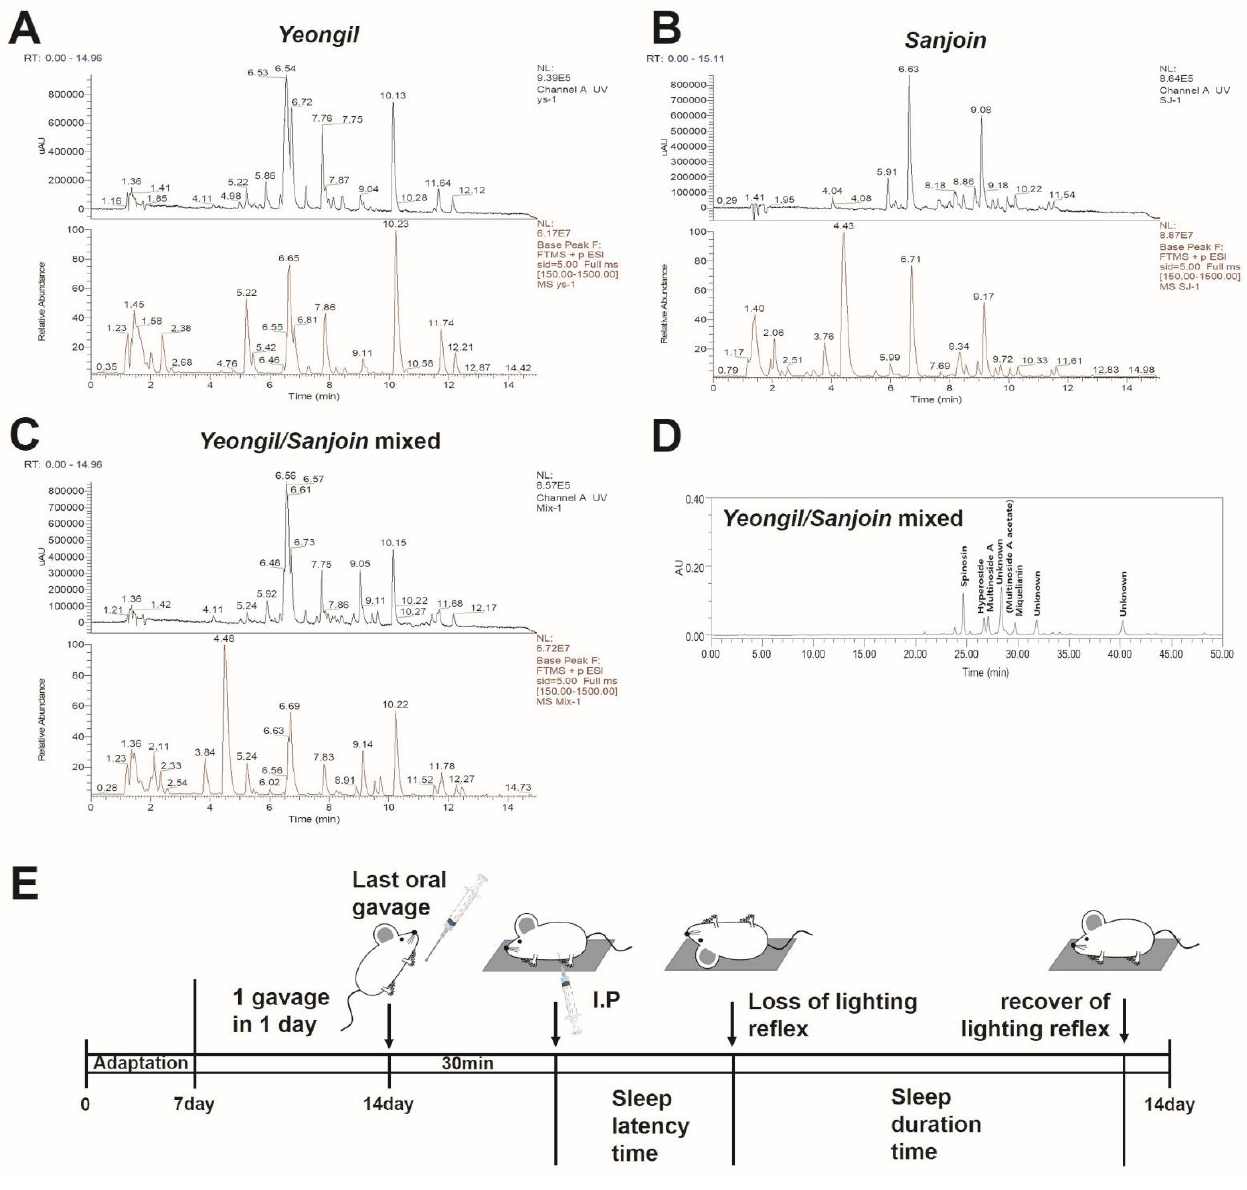
Figure 1. Confirmation of active ingredients through LC-MS analysis and anesthetic sleep. The LC-MS result of Rosa multiflora Thunb. (Yeongsil) ( A ). The LC-MS result of Zizyphus jujuba Miller (Sanjoin) ( B ). The LC-MS result of NCP mixed with Rosa multiflora Thunb. (Yeongsil) and Zizyphus jujuba Miller (Sanjoin) in a ratio of 6:4 ( C ). Quantitative results of NCP by HPLC ( D ). A schematic diagram of the pipeline of the sleep induction experiment ( E